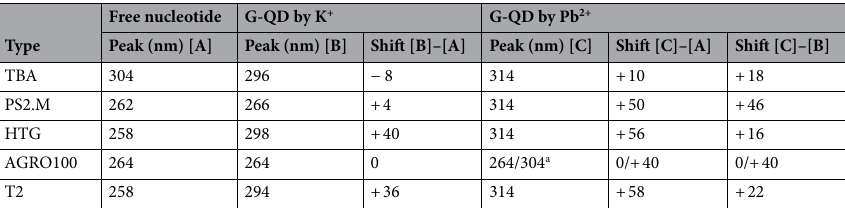
Table 2. CD spectral characteristics for each G-QD owing to addition of K + and Pb 2+ . a For AGRO 100, Pb 2+ ions induced a negative increase in the peak height at 304 nm according to the Pb 2+ concentration, which is a unique wavelength for Pb 2+ . A positive increase in peak height was observed at 264 nm, which was identical to the response of K + and Pb 2+ . In this study, negatively increased peaks were considered as an original response to Pb 2+